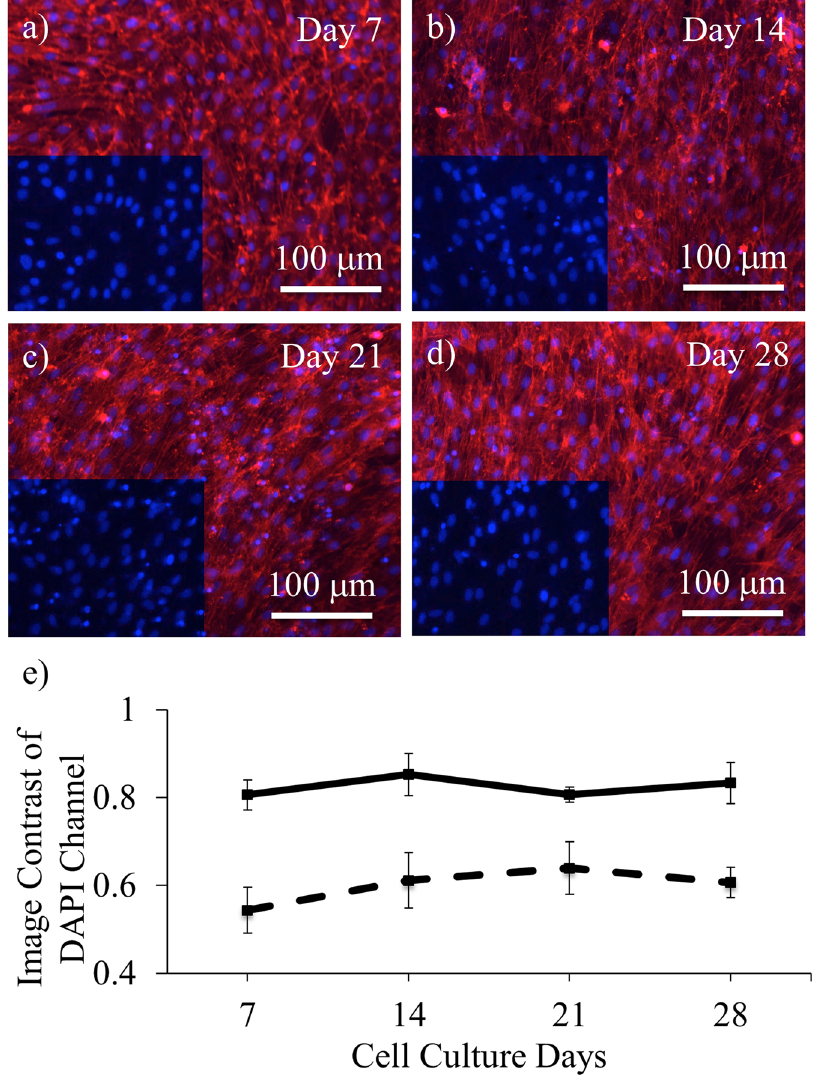
Figure 4. The autofluorescence suppression of pre-culture SBB treatments during long-term culturing. ( a – d ) Fluorescence images of F-actins and nuclei of 3T3 fibroblasts cultured for 28 days on PCL slabs with 0.3% pre- culture SBB treatments. ( e ) The image contrast comparison in DAPI channel. The SBB-treated samples are denoted by the solid line and non-treated samples by the dash line. For each group, there is no statistically significant change in the image contrast over time. For ( a )–( d ), the cells were stained by rhodamine-phalloidin and DAPI on Days 7, 14, 21, and 28 of cell culturing. Red denotes F-actins; and blue denotes cell